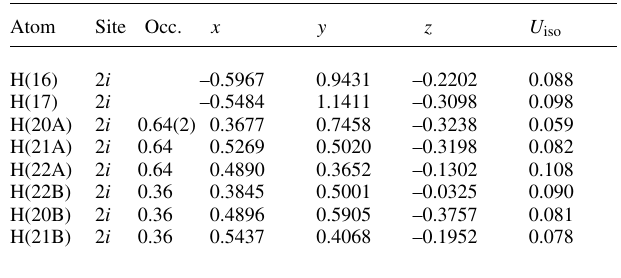
Table 2. Atomic coordinates and displacement parameters (in Å 2 ) .